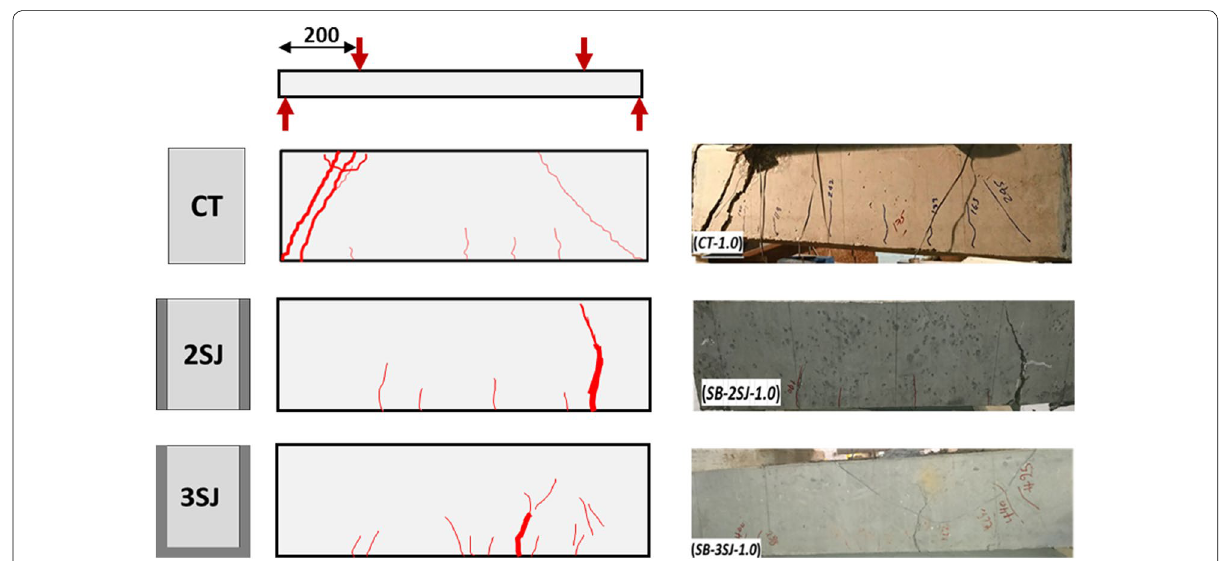
Fig. 10 Crack patterns of beams with a / d